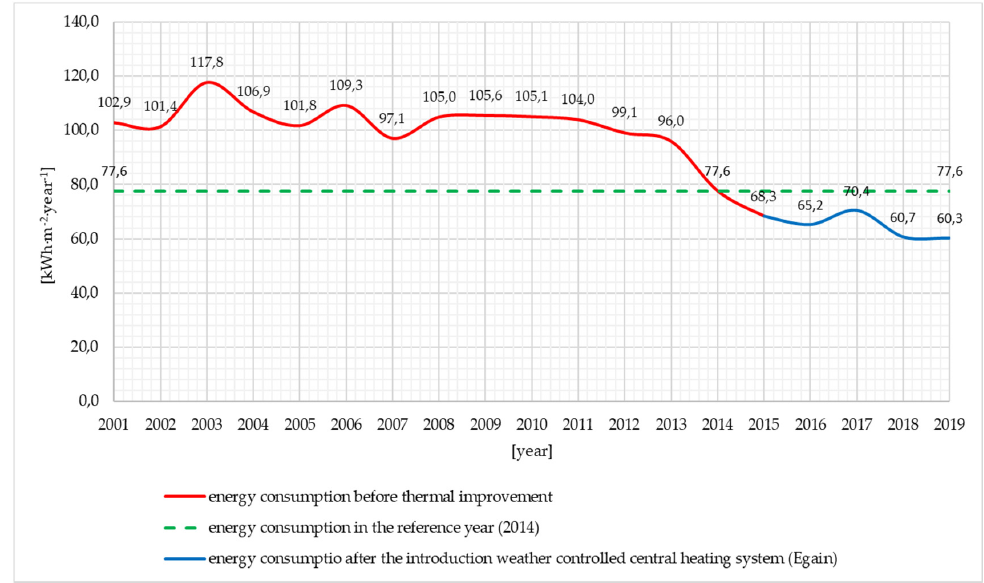
Figure 3. Thermal energy consumption for central heating in the years 2001–2019 in building B.